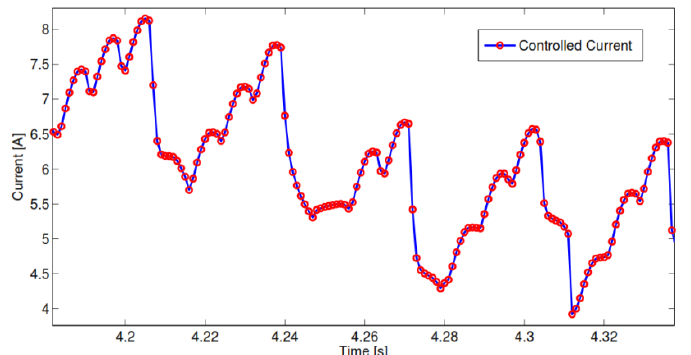
Figure A2. The shape of the phase